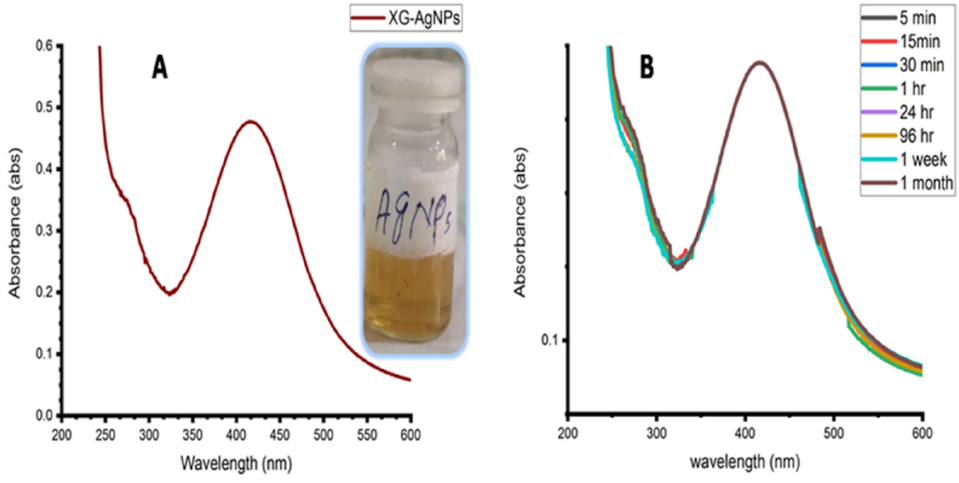
Figure 2. ( A ) UV–Vis spectra; and ( B ) Stability profile of